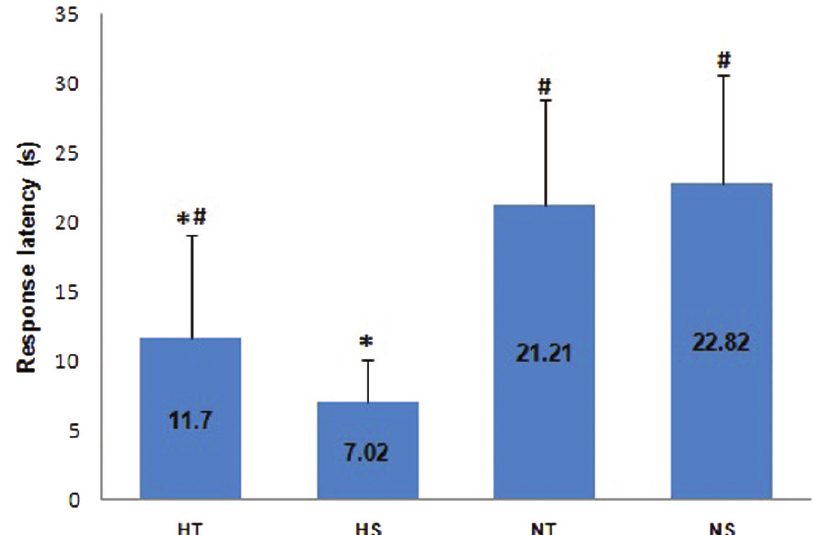
Figure 2 - Response latency of the trained STZ-induced diabetic (HT, n=11), sedentary STZ-induced diabetic (HS, n=9), normoglycemic trained (NT, n=14) and normoglycemic sedentary (NS, n=16) groups. The Kruskal Wallis test was used. * p , 0.01: different from NS and NT; # p , 0.05: different from